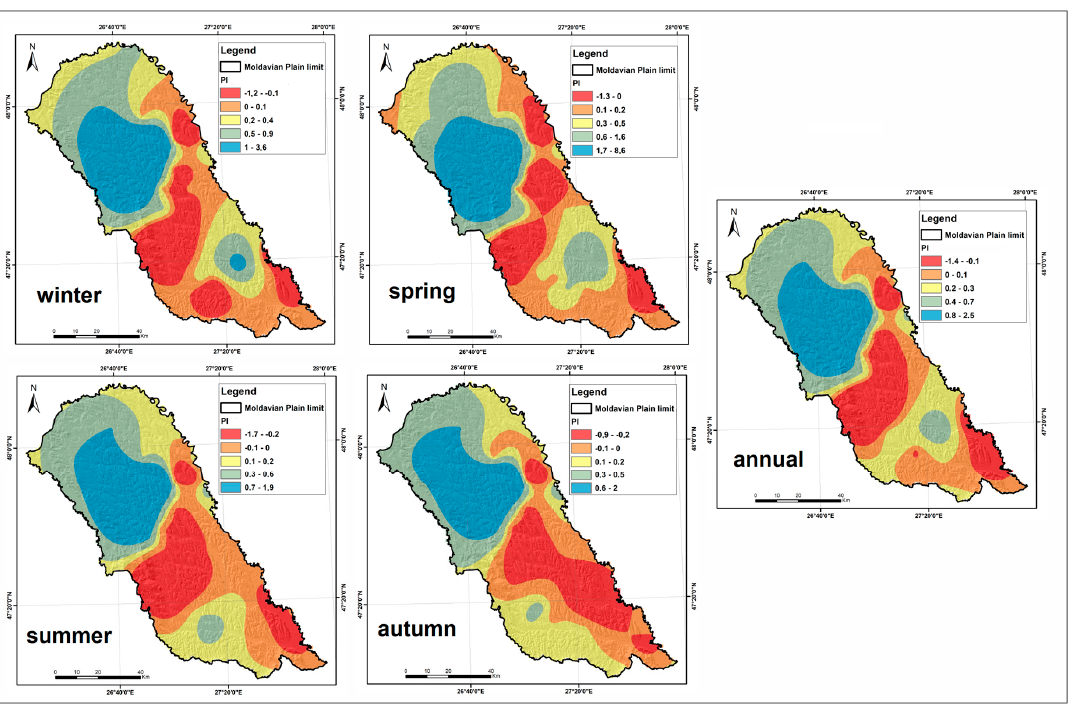
Figure 9. ITA index distribution for annual and seasons periods.